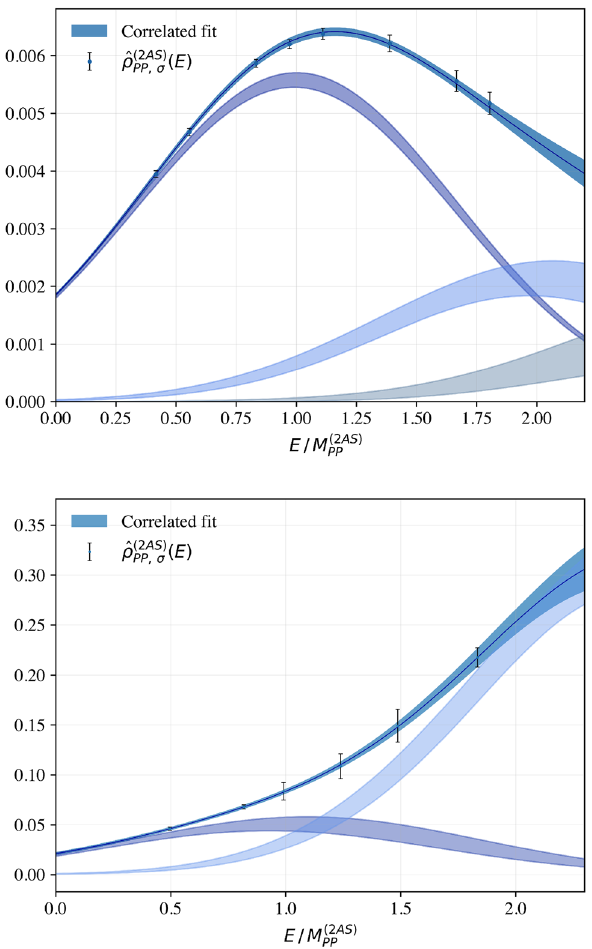
Fig. 11 Examples of fits of spectral densities, showing the breakdown of the contribution of each Gaussian. On the top panel, a three Gaussian fit of a smeared spectral density extracted from a correlator that uses smeared, non-local fields. Due to this choice for the interpolator, the Gaussians in the plot contribute less as we go higher in the energy range. On the bottom panel, we show a similar plot obtained from local interpolators: the two Gaussian fit is still able to isolate the ground state even if the effective mass does not plateau. Both plots correspond to the pseudoscalar 2AS channel. The top panel is obtained within the ensemble B3 and the spectral density has smearing radius σ = 0 . 24 / a . The bottom panel is derived from the ensemble B2 and the smearing radius of the spectral density is σ = 0 . 3 / a